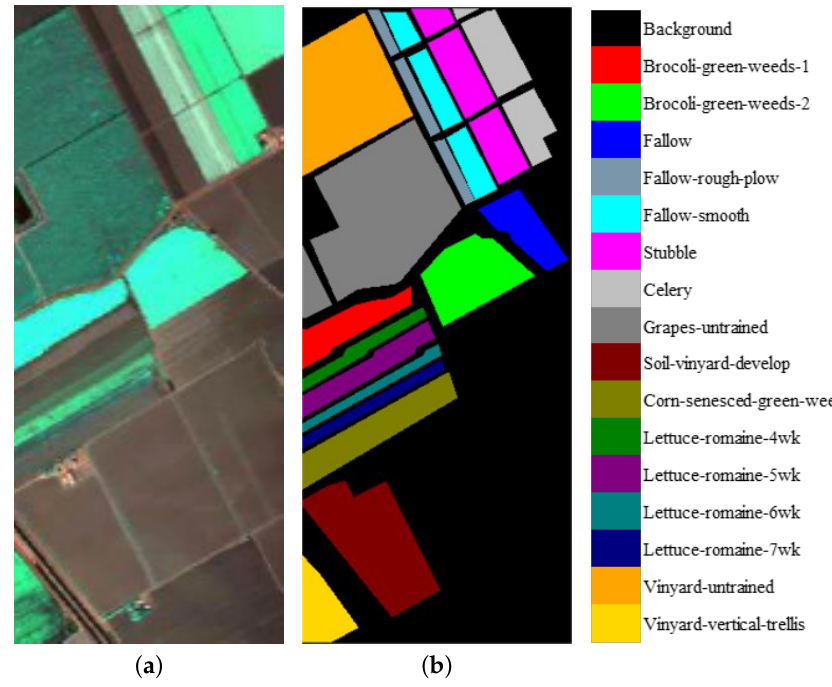
Figure 6. ( a ) False-color Salinas image. ( b ) Ground-truth map of the Salinas data